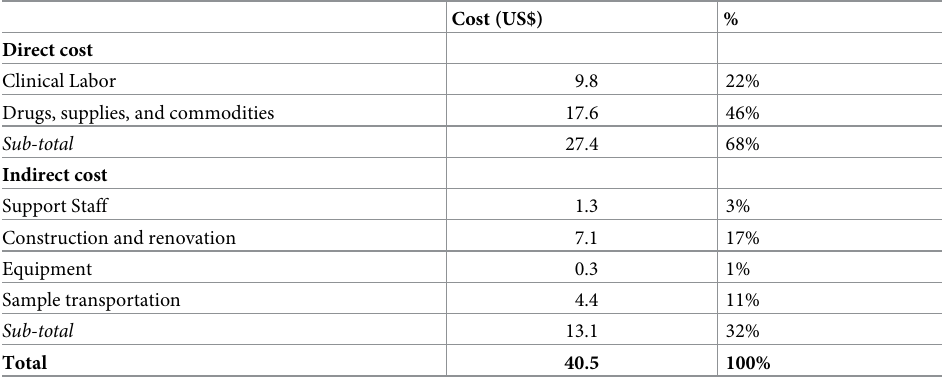
Table 1. VEID unit